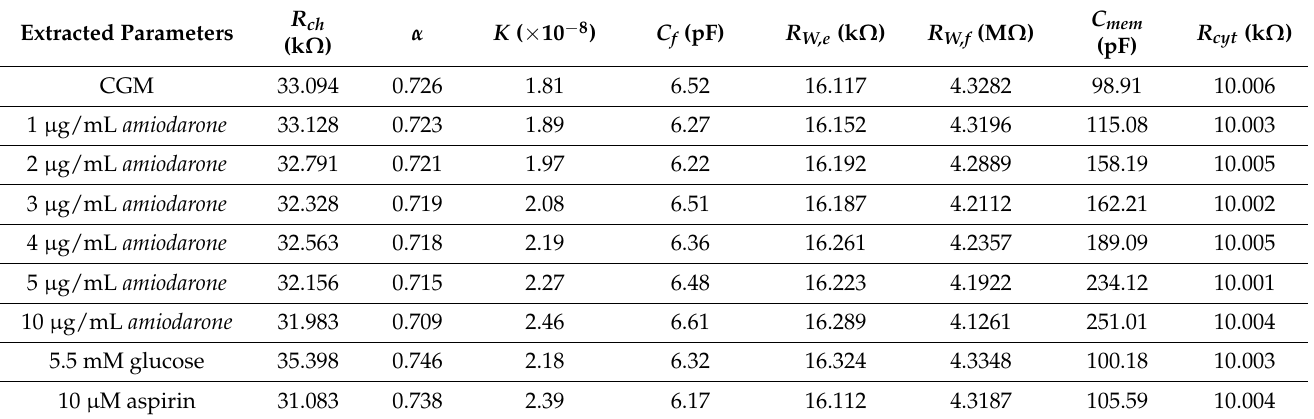
Table 2. Extracted equivalent circuit and cell parameters before (CGM) and 70 s after (CGMD) introducing various drugs (corresponds to 400 s after starting the